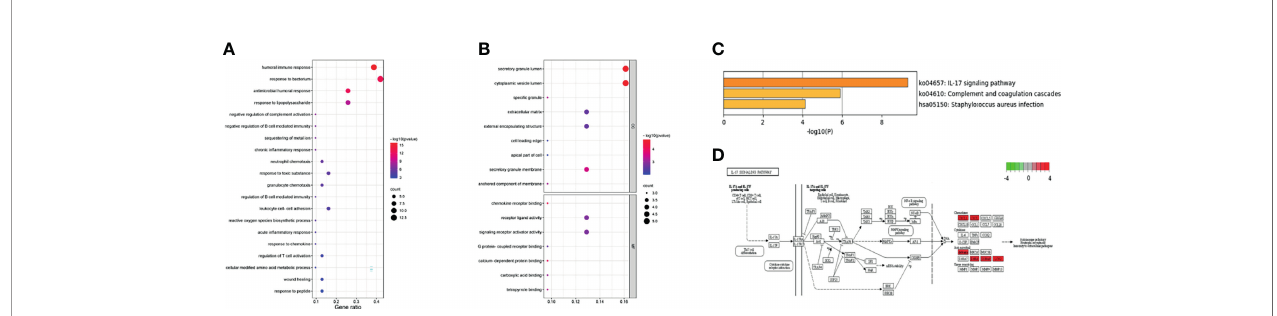
FIGURE 4 | Gene Ontology (GO) and Kyoto Encyclopedia of Genes and Genomes (KEGG) enrichment analysis. (A) The biological processes (BP). (B) The molecular function (MF) and cell composition (CC). (C) The KEGG pathway enrichment. (D) Data on KEGG graph rendered by Pathview.